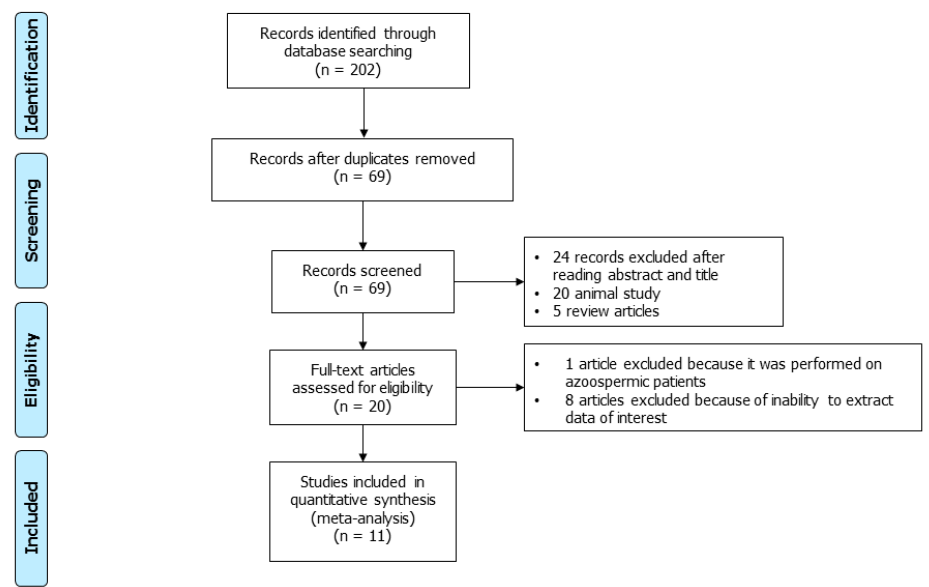
Figure 1. PRISMA fl owchart of the included studies. Figure 1. PRISMA flowchart of the included Table 2. Main characteristics of included cross-sectional studies.